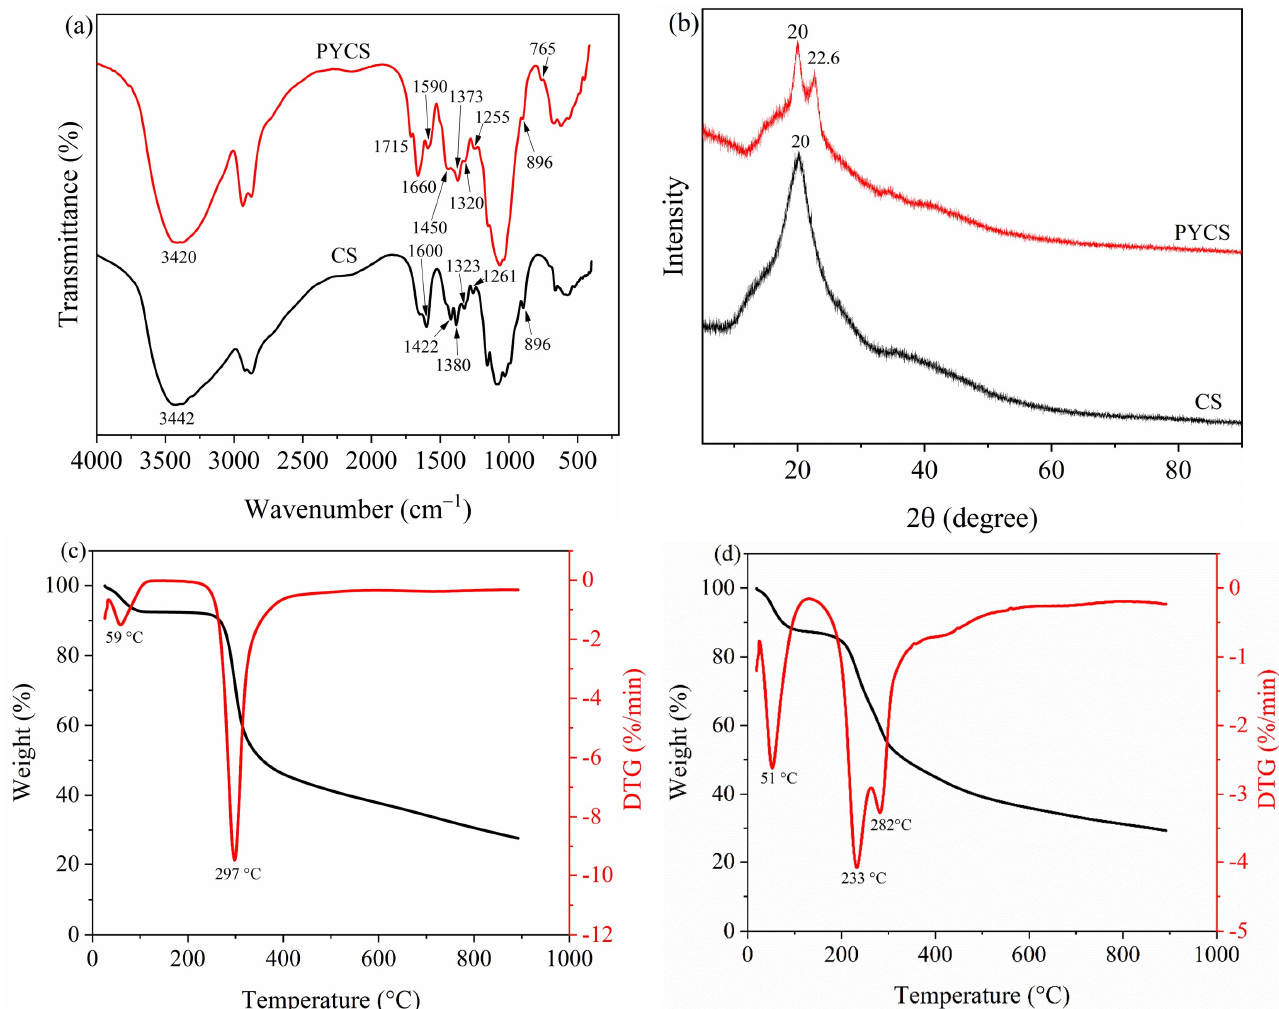
Figure 2. ( a ) FTIR spectra, ( b ) XRD spectra, and TGA–DTG curves (( c ): CS, ( d ): PYCS).